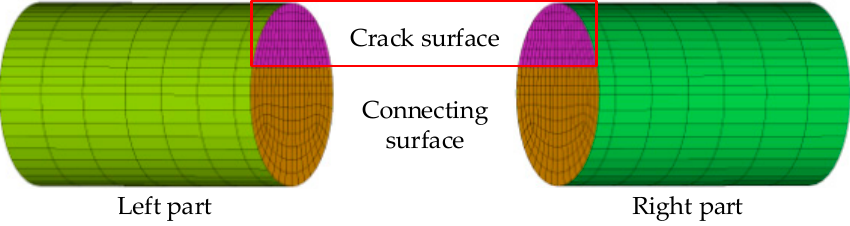
Figure 1. The schematic diagram for the modeling of a gapless crack.